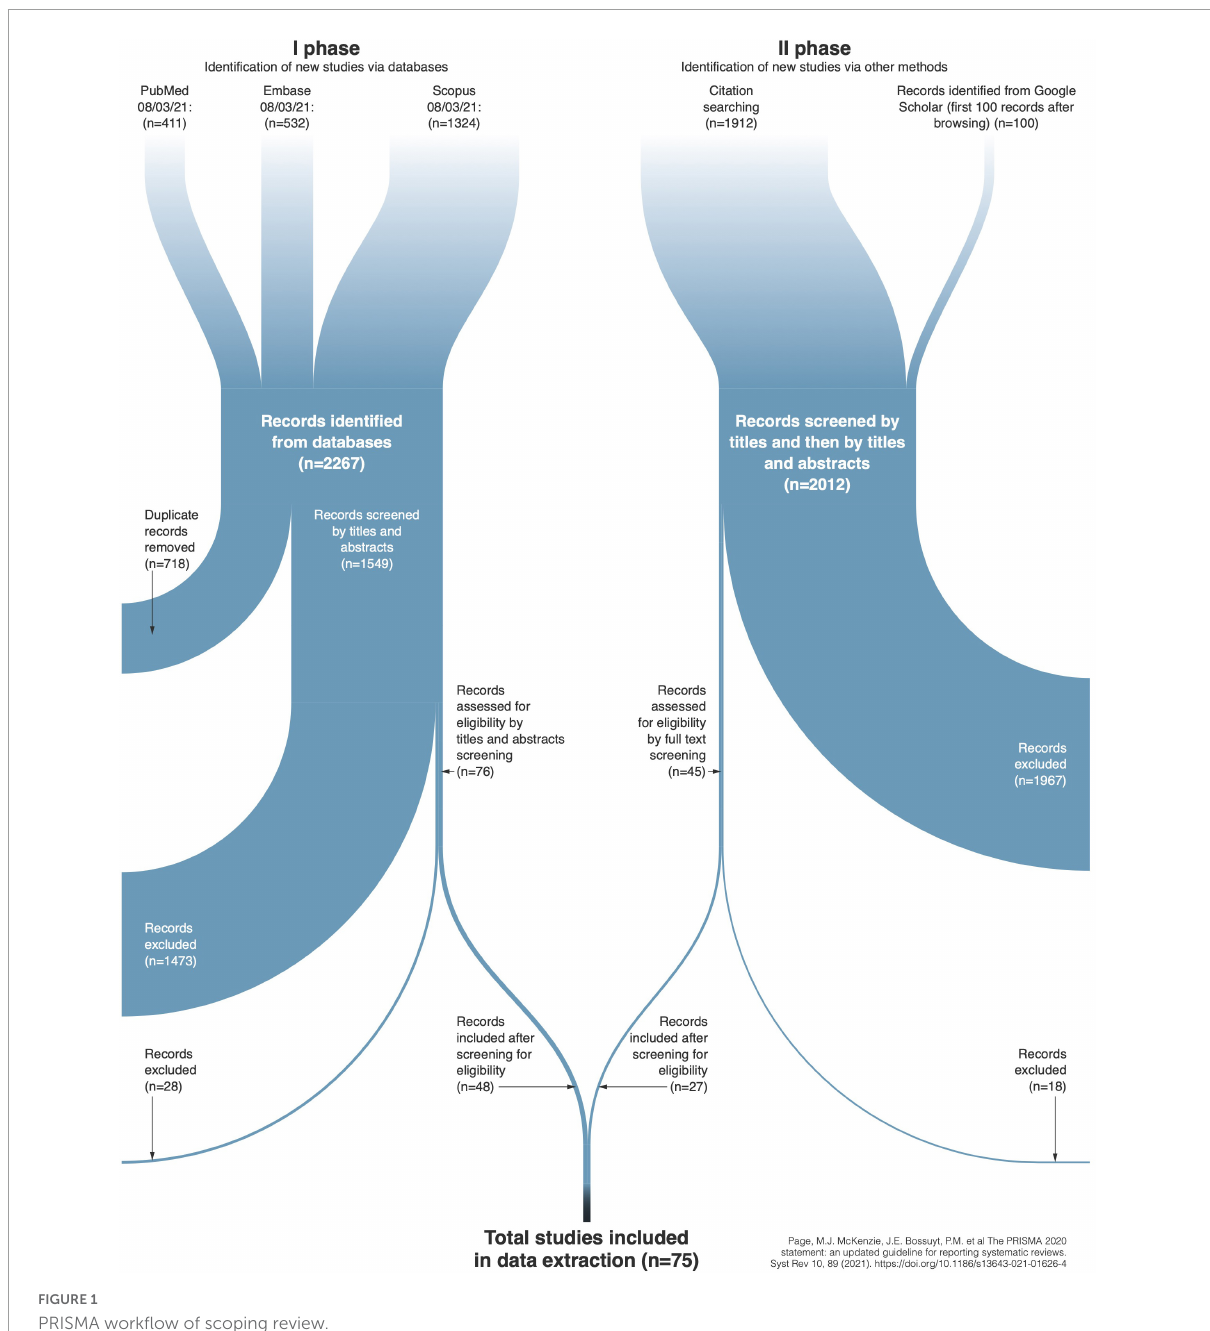
FIGURE1 PRISMA workflow of scoping